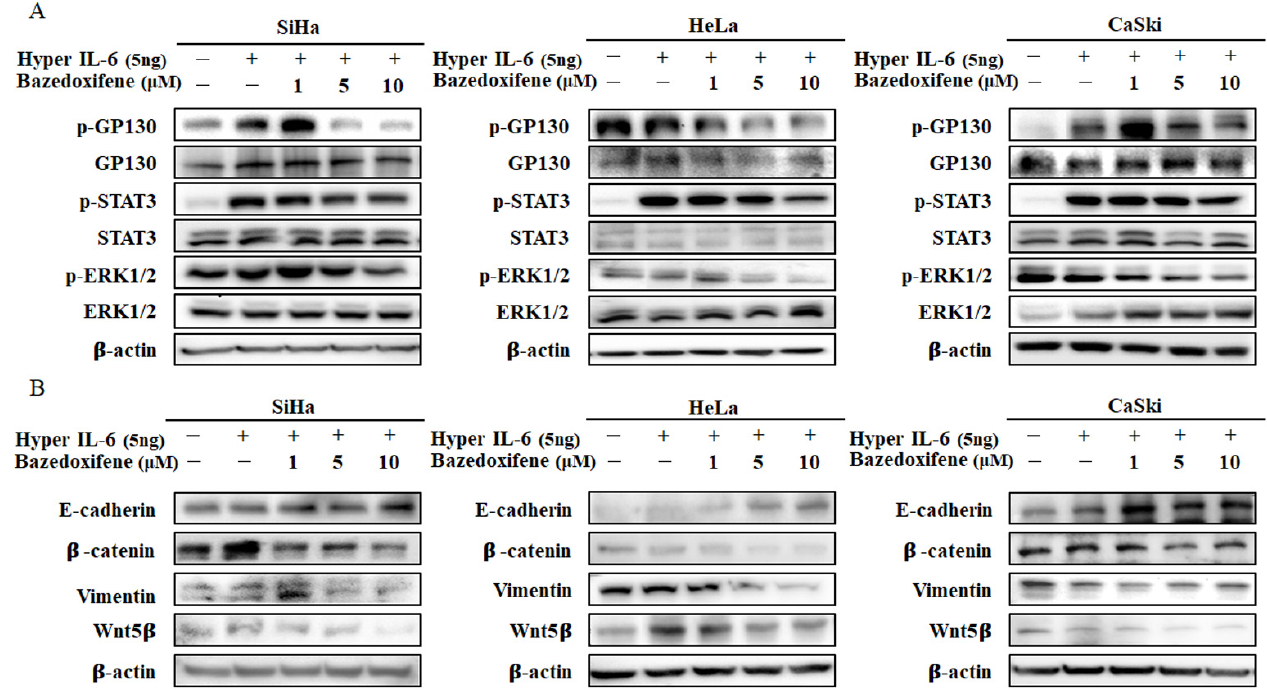
7 of 14 Figure 4. Expression analysis of apoptosis marker proteins in Bazedoxifene-treated SiHa cells. ( A ) Cells were treated for 48 h with the indicated doses of Bazedoxifene. Cell extracts prepared after treatment were resolved by SDS-PAGE and analyzed by Western blot analysis with antibodies against the indicated proteins. ( B ) The band intensities were quanti- tated. The loading control was β -actin. Bars indicate mean ± standard deviation of three independent experiments per- formed in triplicate (***, p < 0.001 vs. control). B: Bazedoxifene. 2.4. Bazedoxifene Inhibits p-GP130/p-STAT3 and EMT Signaling The ability of Bazedoxifene to inhibit GP130/STAT3 signaling was evaluated in SiHa, HeLa, and CaSki cervical cancer cells. Bazedoxifene dose-dependently reduced the ex- pression of p-STAT3 and p-GP130 compared with hyper-IL-6 in SiHa, HeLa, and CaSki cells (Figure 4A). In addition, Bazedoxifene may affect other downstream targets of GP130. The results show that the expression of p-ERK1/2 was downregulated compared to hyper-IL-6 in SiHa, HeLa, and CaSki cells, and the magnitude of downregulation de-